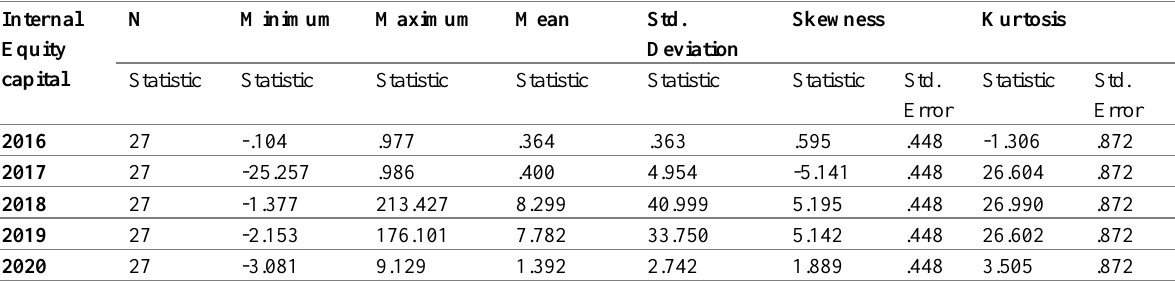
Table 2: Internal Equity Descriptive